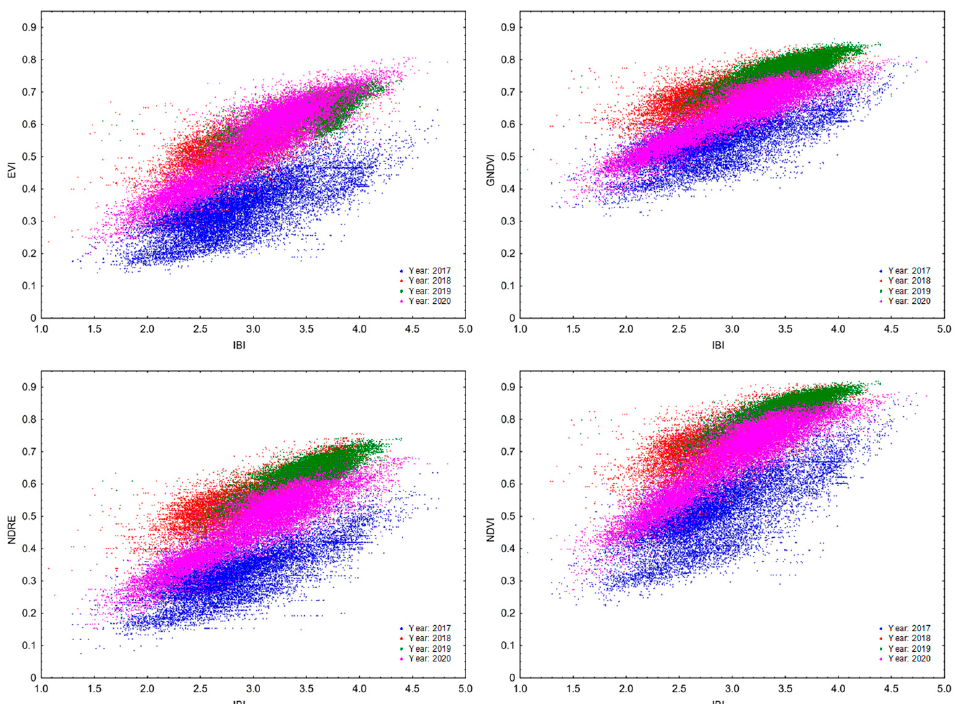
Figure 7. Spearman’s rank correlation coefficient and scatter graph showing the correlation between the IBI vegetation index and vegetation indexes EVI, GNDVI, NDRE and NDVI in the respective years of the experiment. Table 8. Percentage of relative differences between IRMI and NDRE in the individual years 2017–